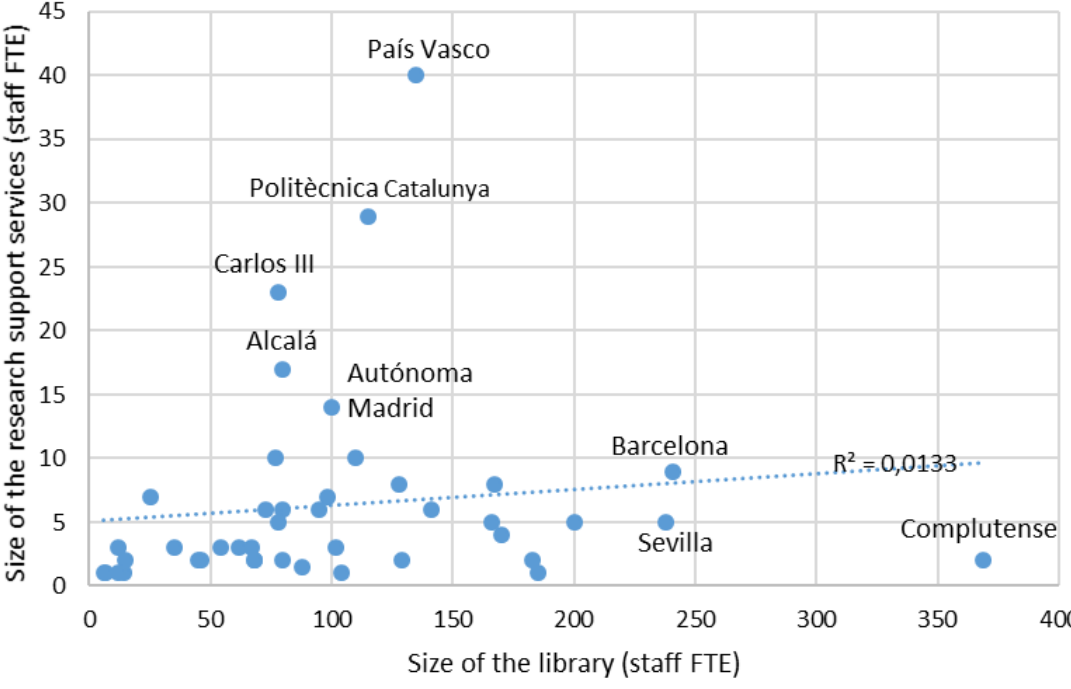
Figure 3. Relationship between size of the library and staff assigned to research support.